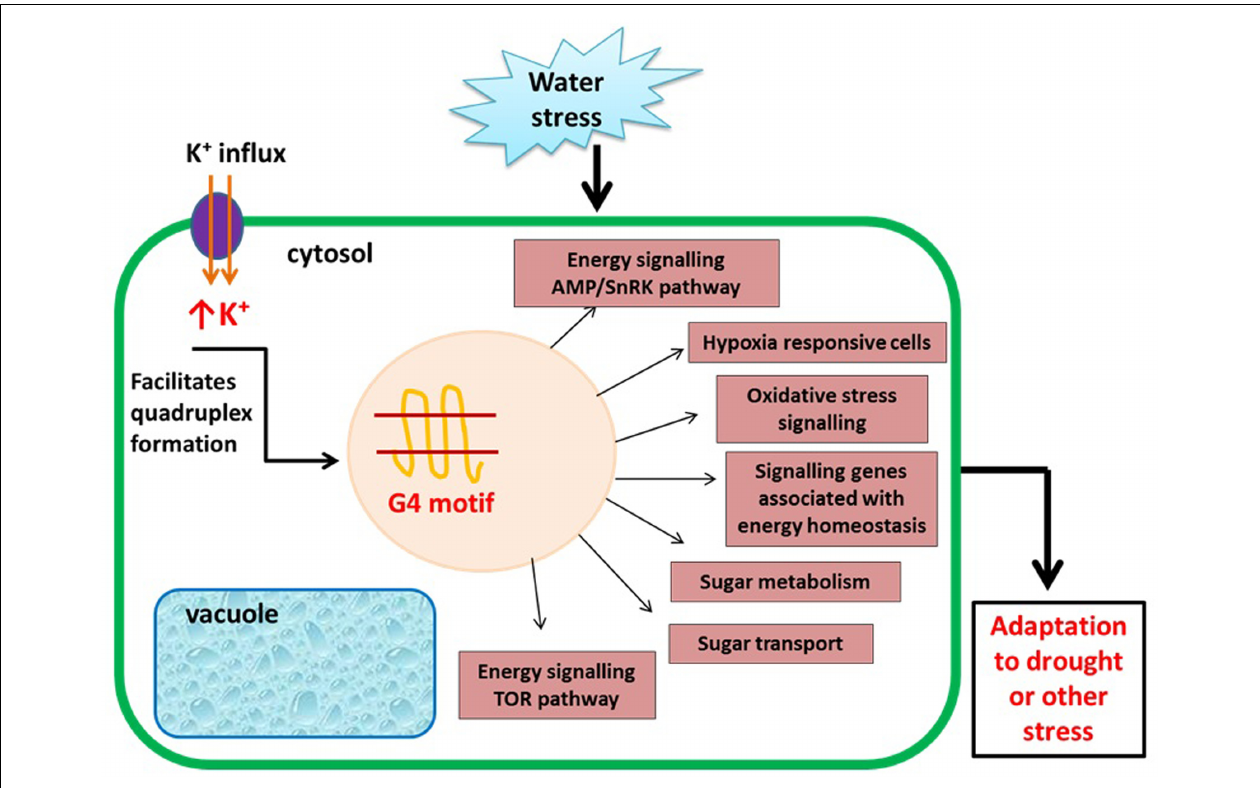
FIGURE 4 | Impediment of DNA Polymerase activity by G